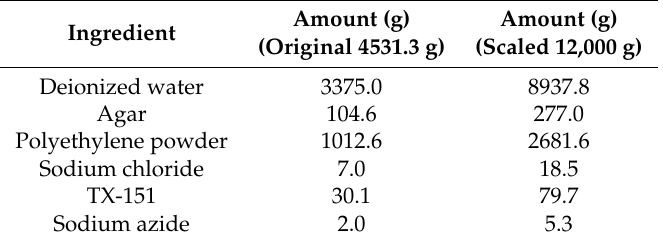
Table 1. Composition of the 2/3 muscle equivalent material.